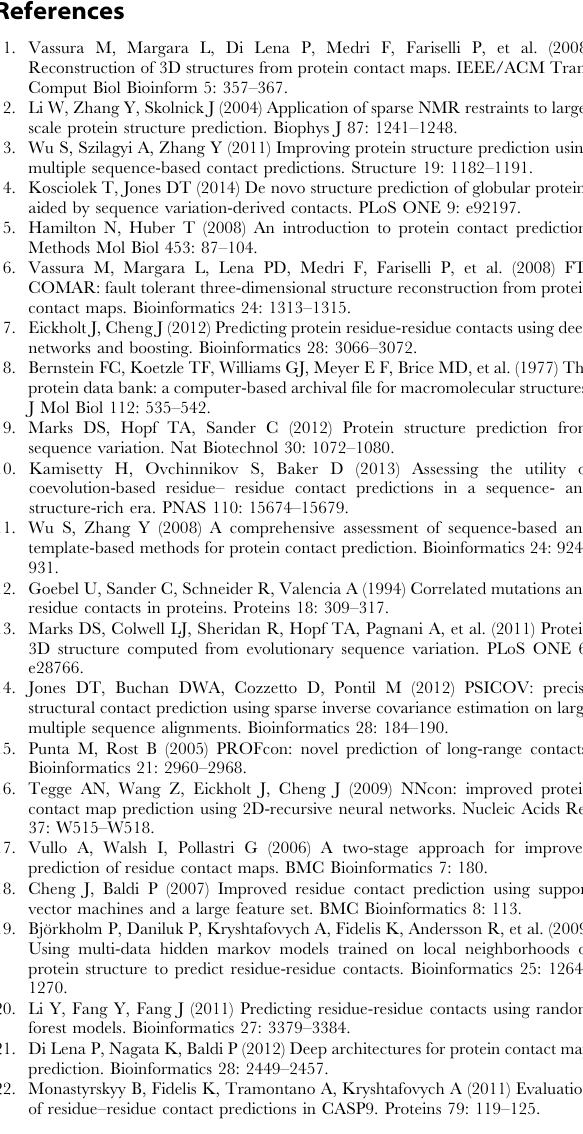
several methods on the CASP10 data set (104 proteins). Table S11, Contact prediction performance of